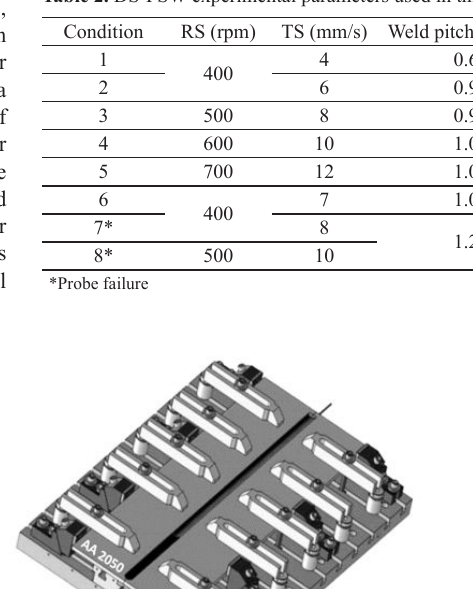
Table 2. DS-FSW experimental parameters used in this study.